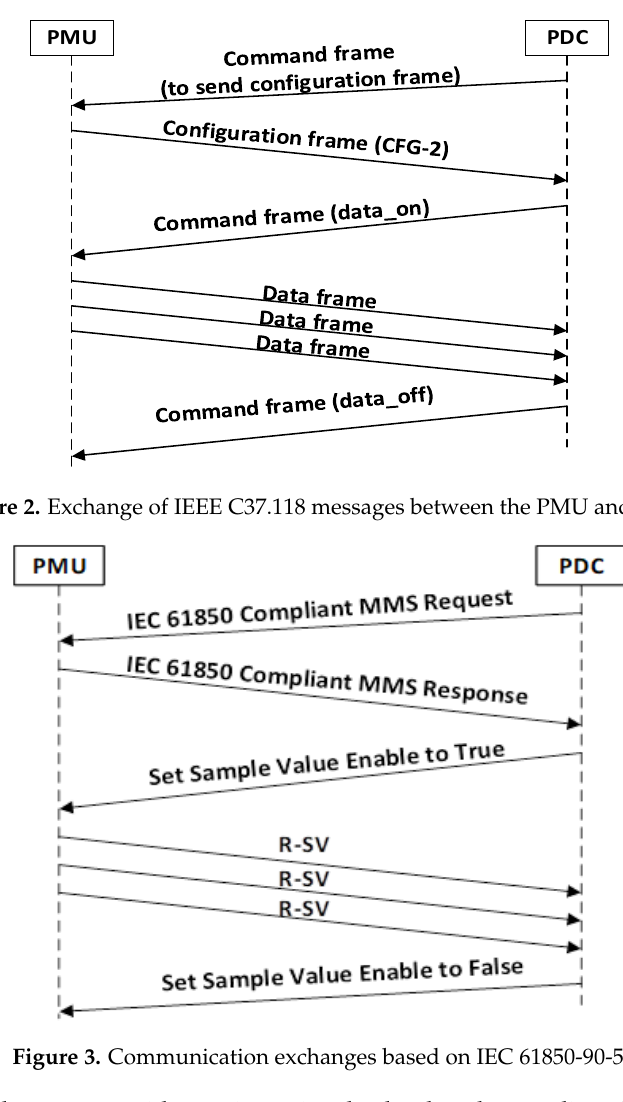
Figure 3. Communication exchanges based on IEC 61850-90-5.